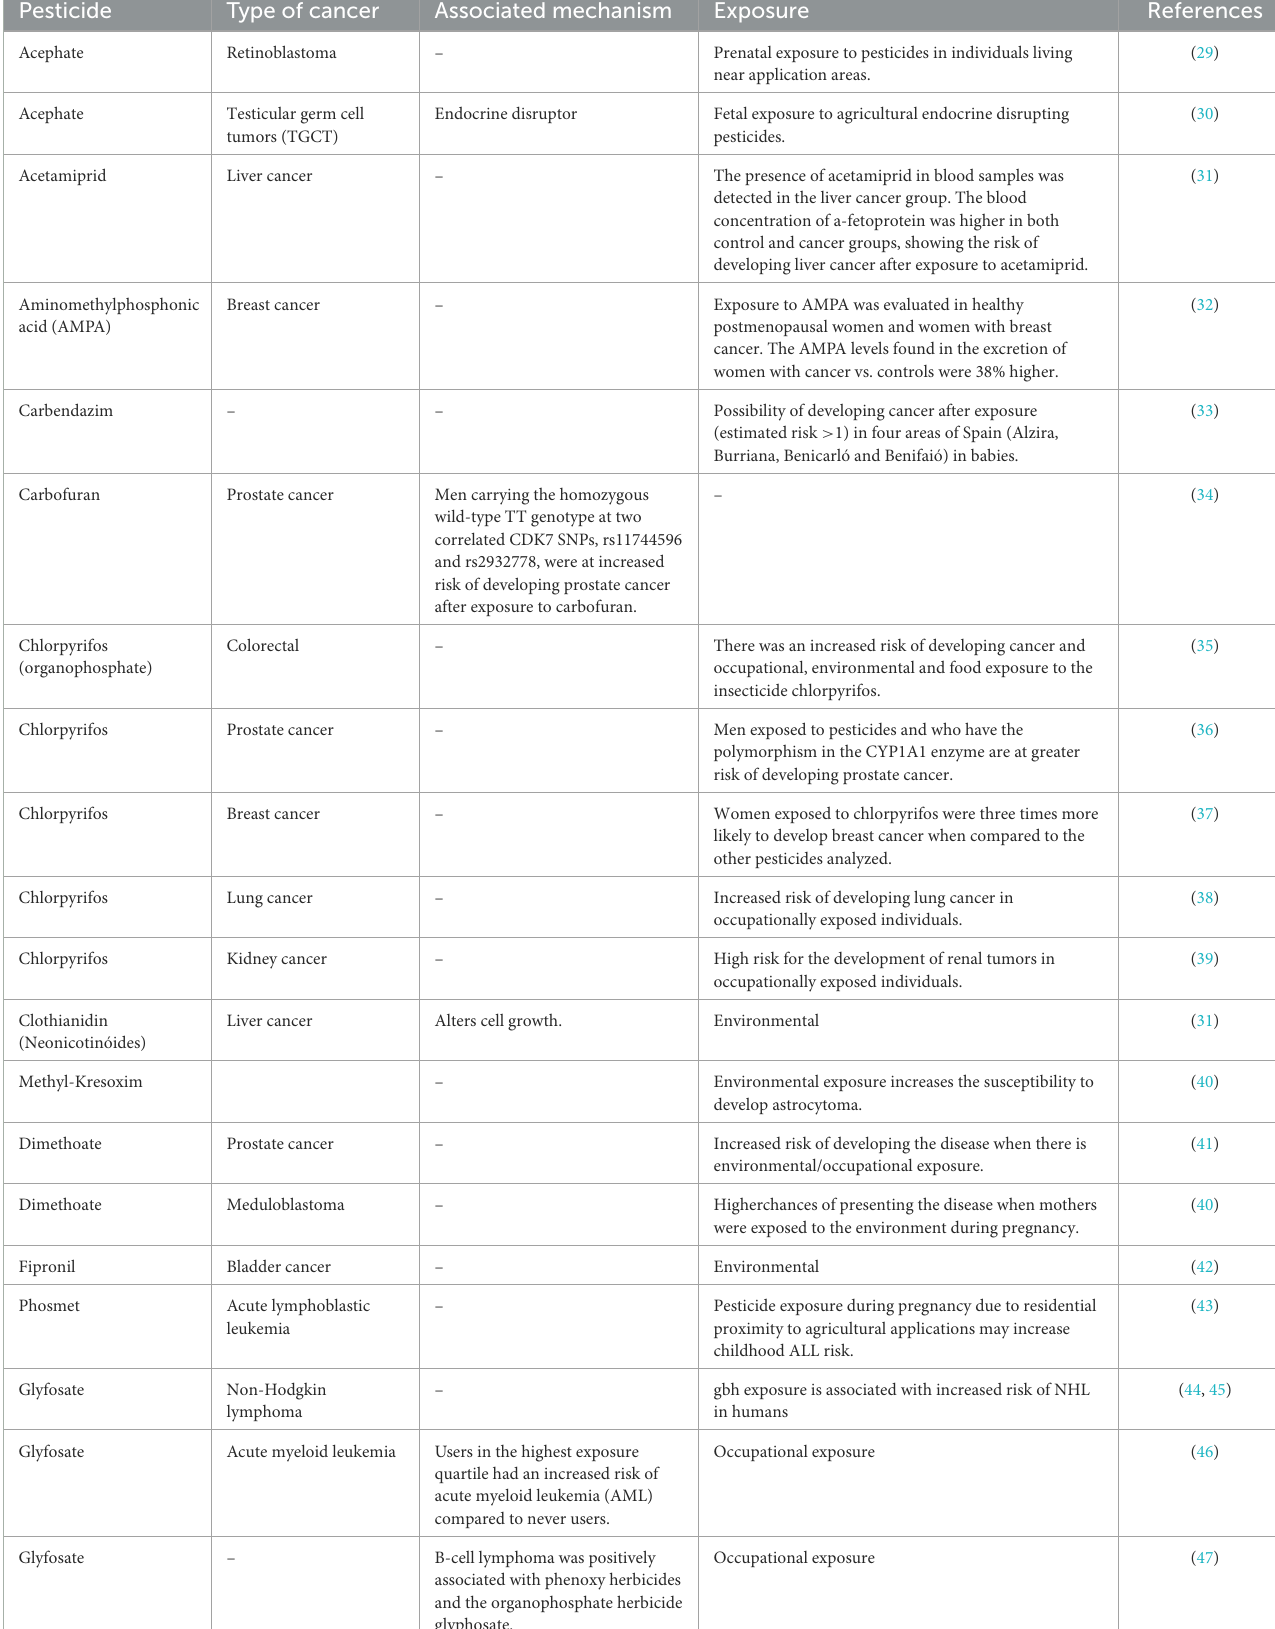
TABLE 4 Mechanisms associated with human carcinogenesis following exposure to pesticides.